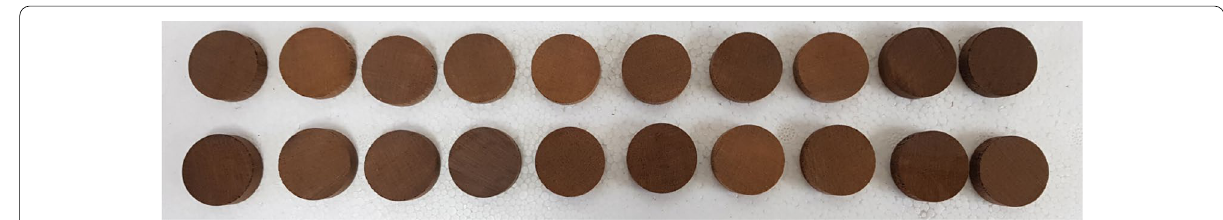
Fig. 1 Malas sample